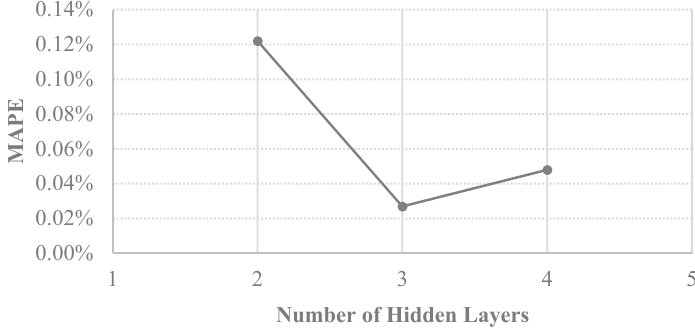
Figure 6. Selection of the number of hidden layers for the deep neural network (DNN) model. Number of Neurons